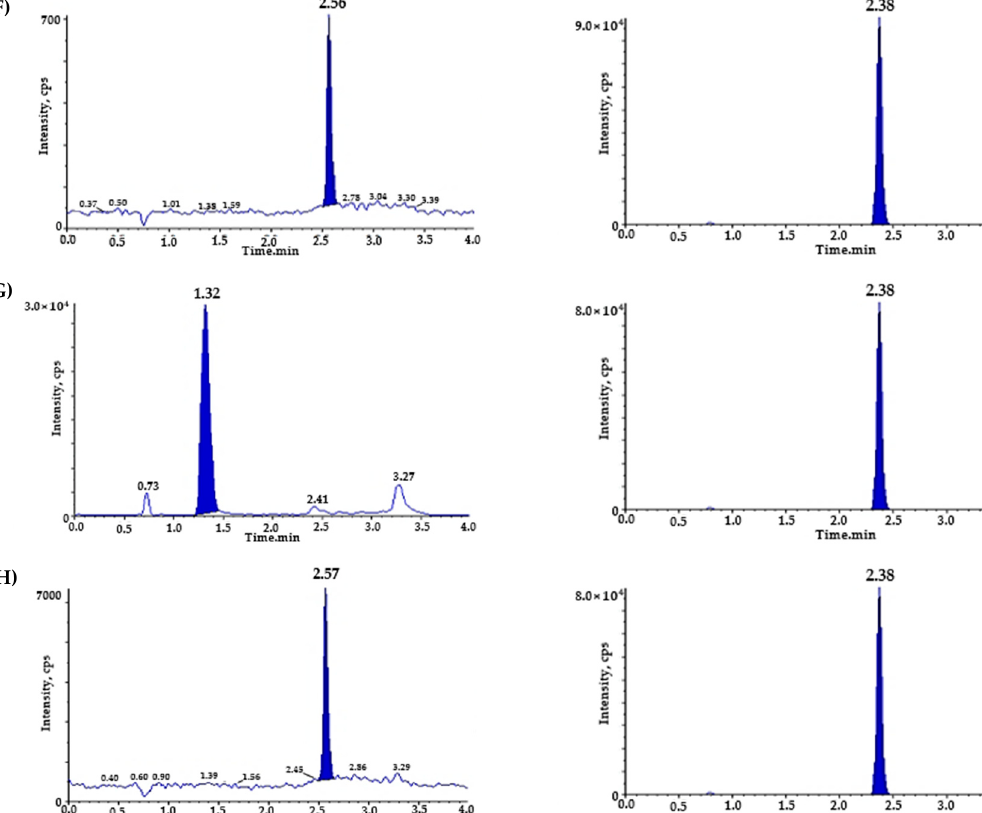
Figure 2. Representative chromatograms of ( A ) double blank plasma (without donepezil, tadalafil, and IS); ( B ) blank plasma spiked with lansoprazole (IS, 20 ng/mL); ( C ) blank plasma spiked with donepezil (ULOQ, 200 ng/mL); ( D ) blank plasma spiked with tadalafil (ULOQ, 200 ng/mL); ( E ) donepezil chromatogram of blank plasma spiked with donepezil, tadalafil (LLOQ, 1 ng/mL), and lansoprazole (IS, 20 ng/mL); ( F ) tadalafil chromatogram of blank plasma spiked with donepezil, tadalafil (LLOQ, 1 ng/mL), and lansoprazole (IS, 20 ng/mL); ( G ) donepezil chromatogram of sample plasma 1 h after oral administration of donepezil (3 mg/kg), measured concentration of donepezil (25.297 ng/mL) and tadalafil (0.3 mg/kg); and ( H ) tadalafil chromatogram of sample plasma 1 h after oral administration of donepezil (3 mg/kg) and tadalafil (0.3 mg/kg, measured tadalafil concentration: 12.943 ng/mL).